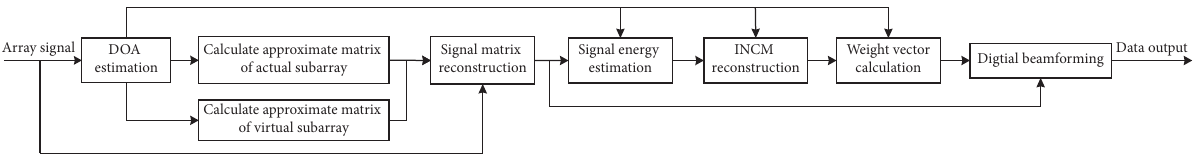
Figure 3: Flowchart of the proposed